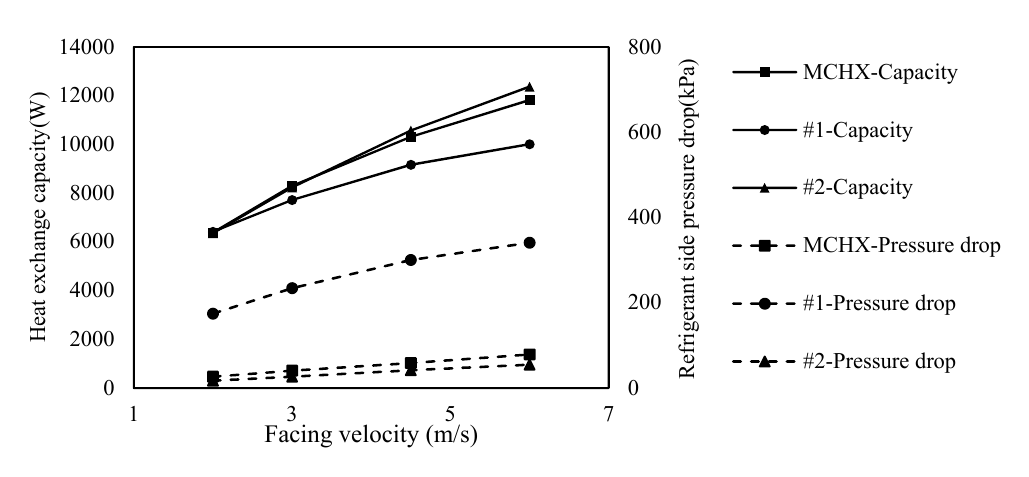
Figure 2. Simulation results under cooling mode.